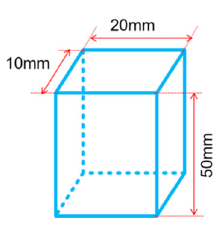
Figure 2: Schematic diagram of iron mold cavity used in the experiment.